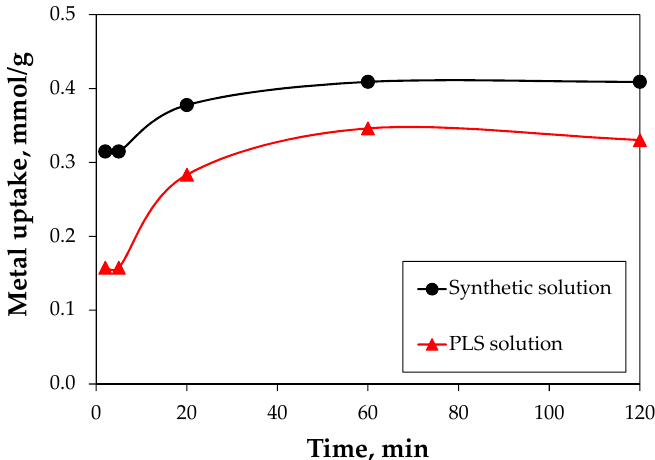
Figure 8. Copper biosorption kinetics of Gracilaria chilensis for synthetic and leached tailing (PLS) solution at pH 1.5 and biomass concentration of 0.5 g/L.